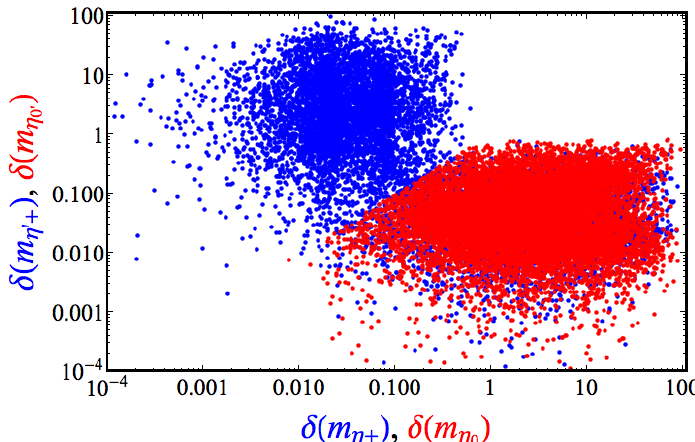
m ) =m of the charged scalar (cid:17) 0 + versus (cid:0) versus (cid:17) 0 , in red. Notice that the red region of points is 0